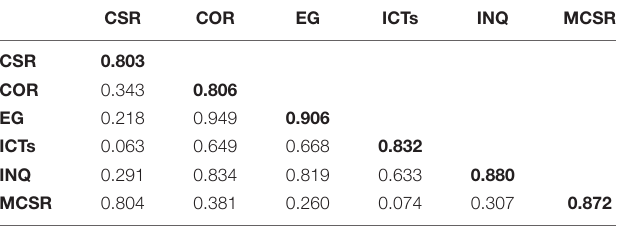
TABLE 3 | Fornell and Larcker